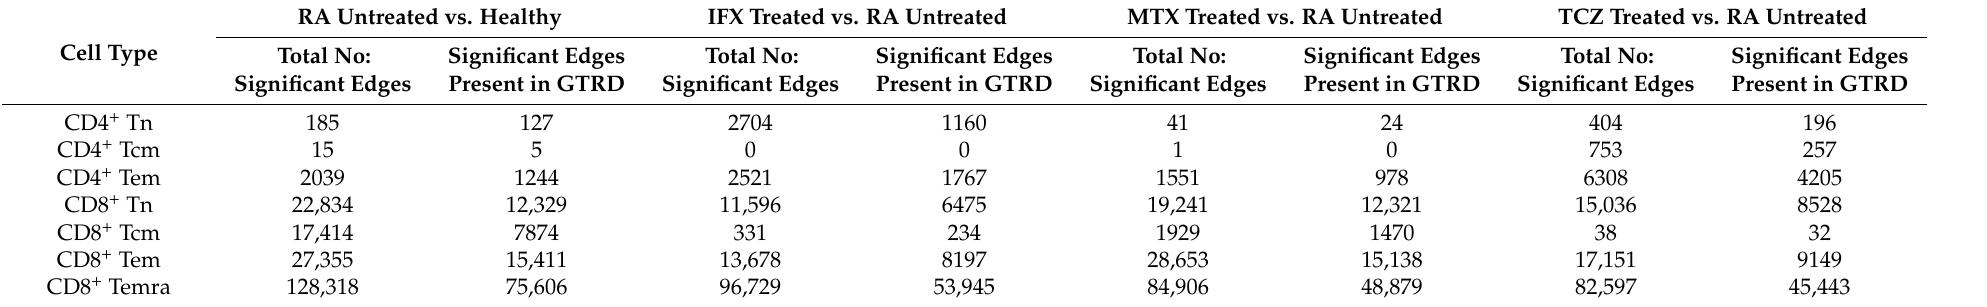
Table 13. Number of significant edges and GTRD-annotated significant edges in T cell subsets.